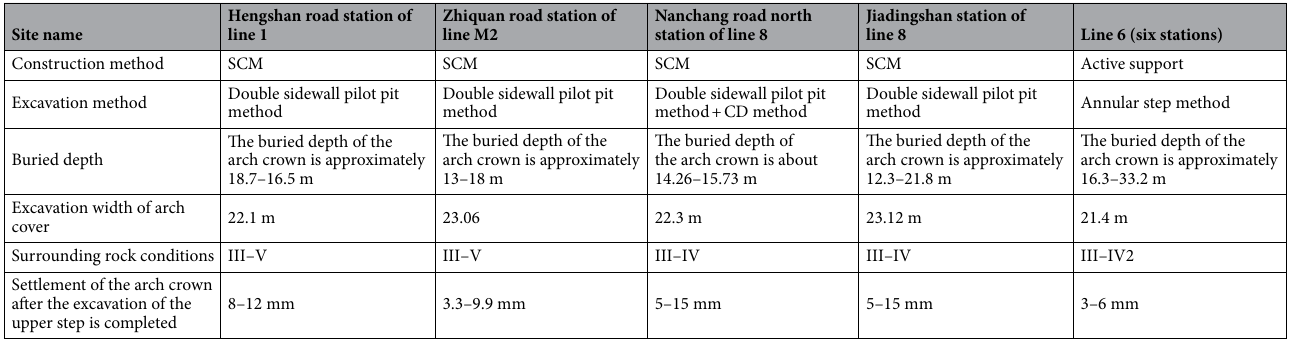
Table 13. Summary of existing line